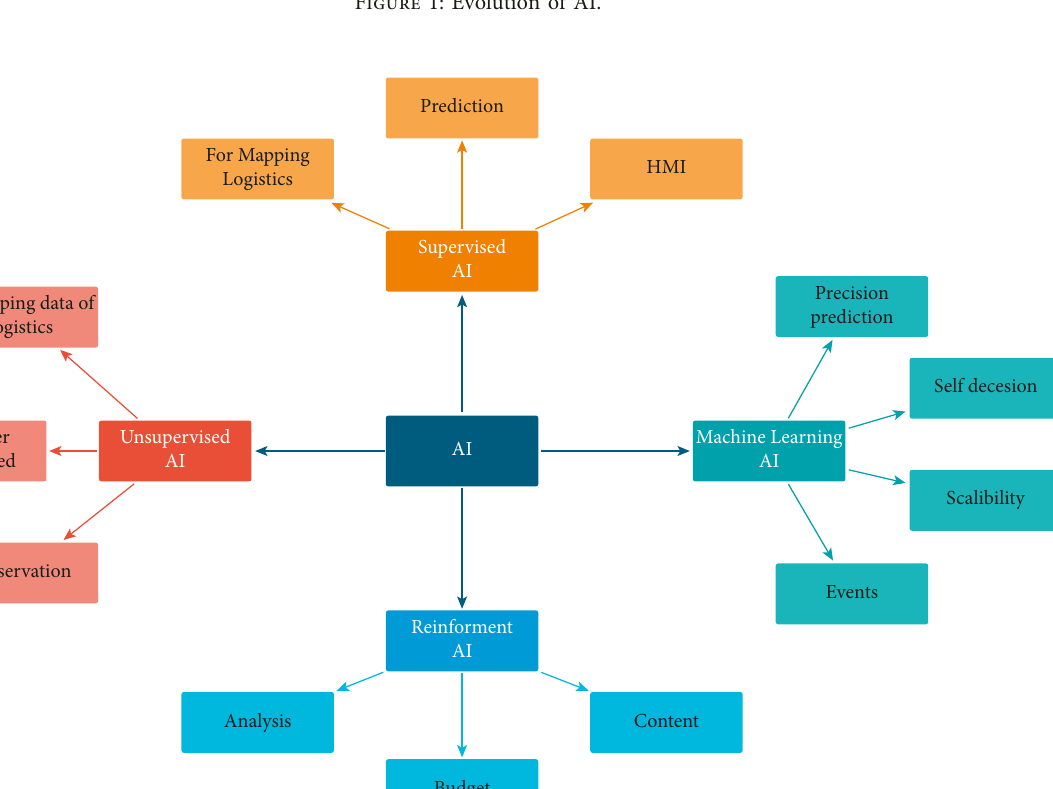
Figure 1: Evolution of